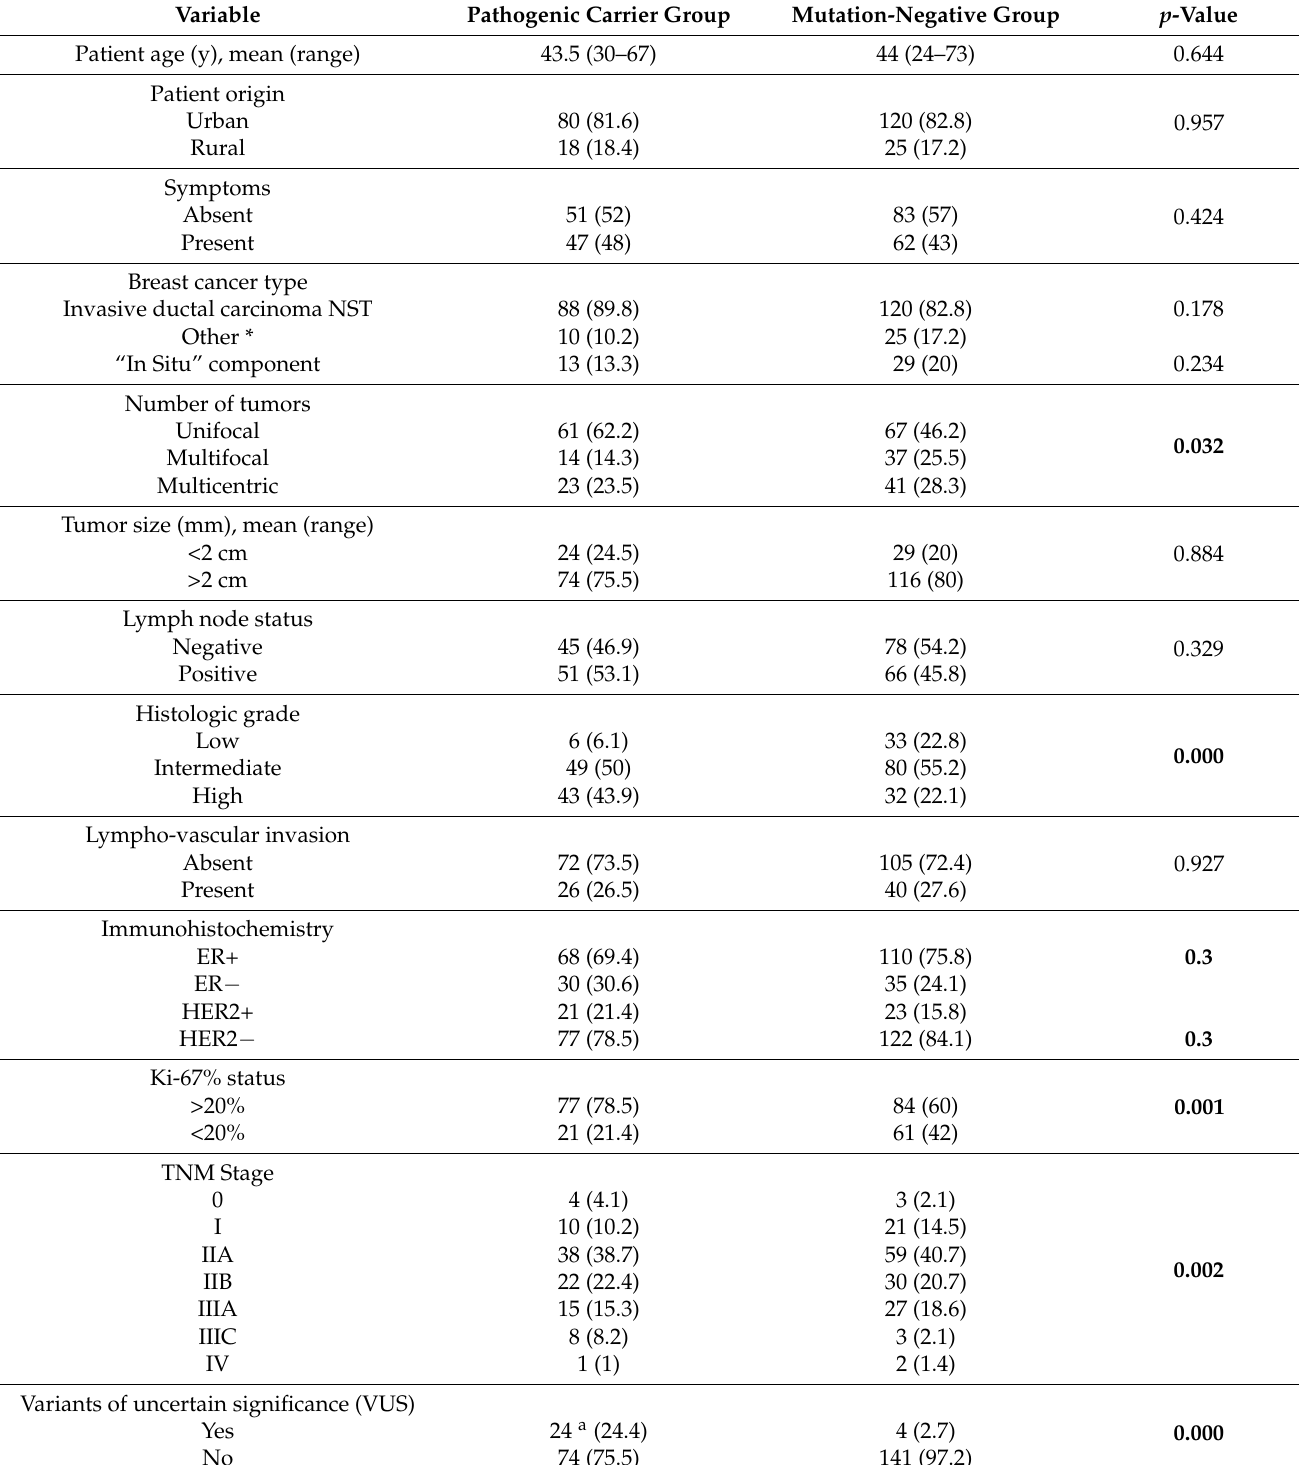
Table 1. Clinic-pathological characteristics of the